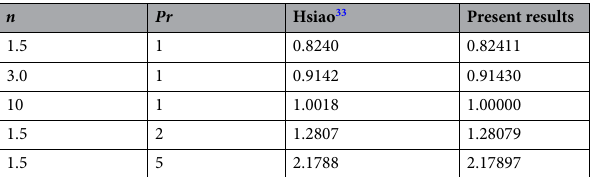
Table 1. Comparative analysis of − θ ′ ( 0 ) obtained by the numerical technique with that of Hsiao 33 for numerous values of n and Pr . Fixing K = M = (cid:31) = 0 and R = 0.2, Ec = 0.1 .